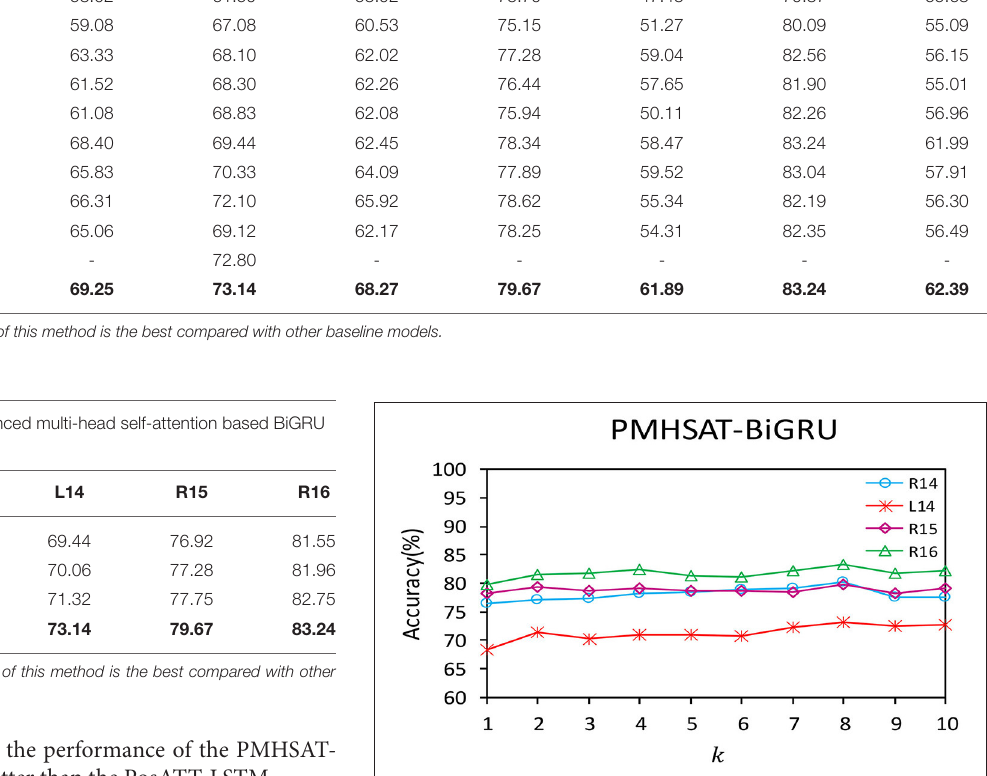
TABLE 3 | The results of the PMHSAT-BiGRU model and baseline models in Semeval2014–2016. R14 L14 R15 R16 Acc Macro-F1 Acc Macro-F1 Acc Macro-F1 Acc Macro-F1 ContextAvg 71.53